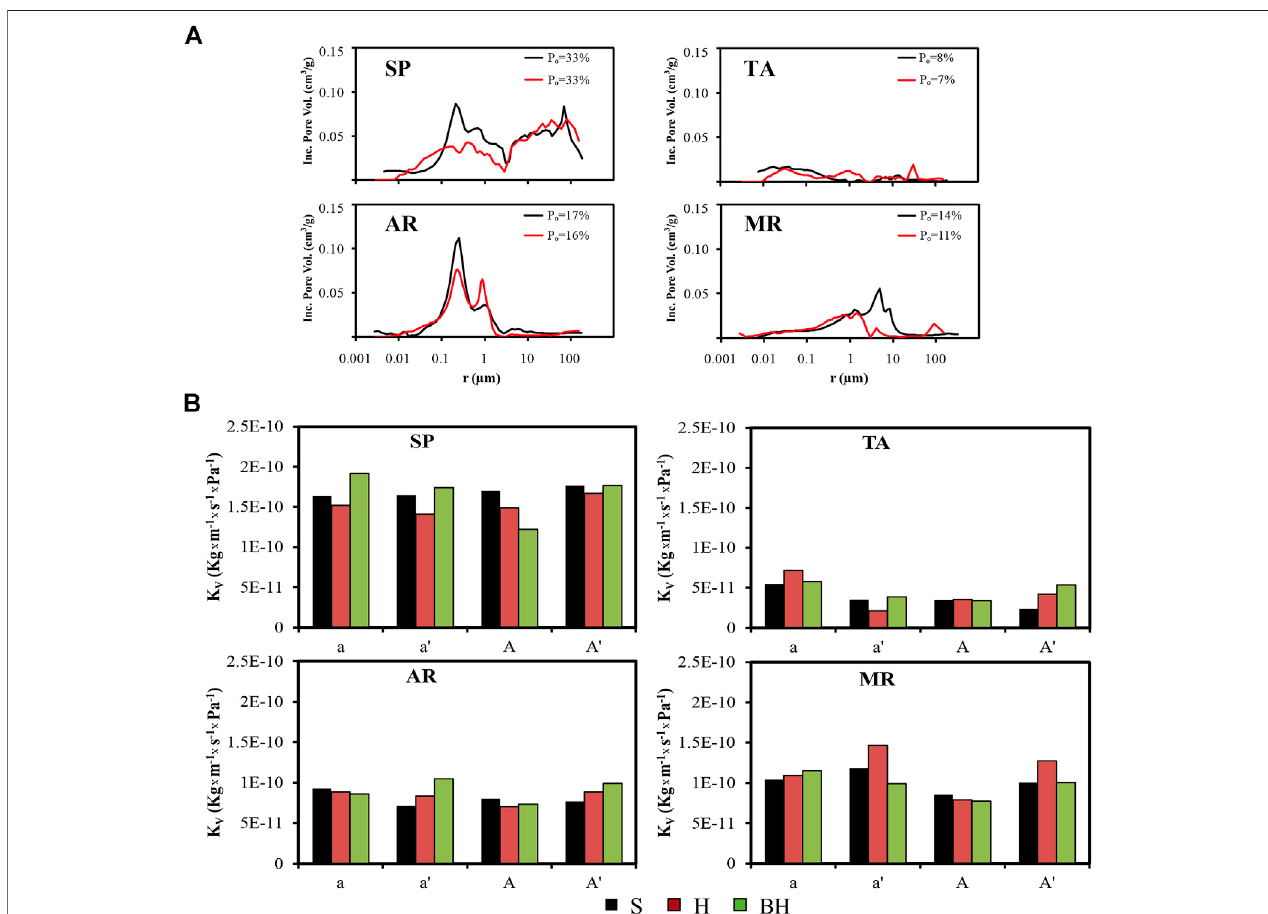
FIGURE4 | Pore size distribution curves (A) foruntreated(blackline) and treated specimens (red line), and (B) water vapor permeability values (K V ,in Kg/m × s × Pa) for the samples exposed to Solution A with regard to each surface fi nish (S: saw-cut, H: honed and BH: bush-hammered) in Calcarenita de Santa Pudia (SP), Travertino Amarillo (TA), Arenisca Ronda (AR) and Molinaza Roja (MR). Legend: P o , open porosity (in %); a and a ′ , fresh samples and desalinated samples without HAP, respectively;AandA ′ ,freshsamplesanddesalinatedsampleswithHAP,respectively;theblack,redandgreenbarsshowtheK V valuefortheS,HandBHsurface fi nishes,